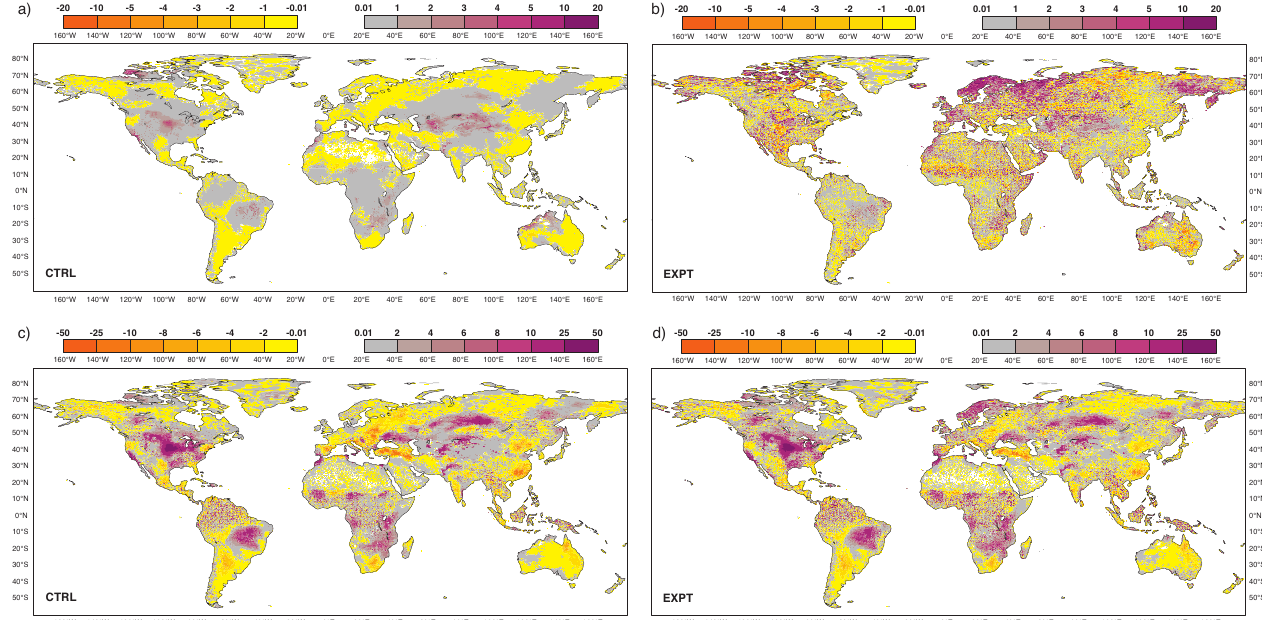
Figure 8. Total soil moisture increments for CTRL (left panel) and EXPT (right panel) for ( a ), ( b ) the top model layer (0–7 cm) and ( c ), ( d ) the deep layer (7–100 cm). The period of analysis spans from 1 to 15 July 2012. Increments are integrated over the depth of the layer and shown in mm